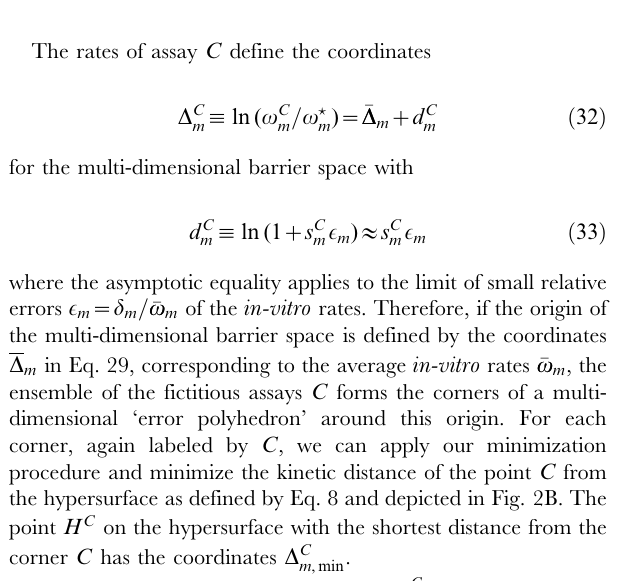
ribosome. The reactions were stopped at the indicated time intervals and translation products separated on 16.5% Tris- Tricine-PAGE and visualized by the fluorescent reporter BOD- IPY-Fl at the N-terminus of the peptides [47] (left panels). The intensity of the full length product was quantified with ImageJ (right panel, circles). Average translation rates per codon, which depend on the elongation rates only, were determined by exponential fitting (fits in graphs of the right panel). Figure S2 In-vitro rates as measured for near-cognate accommodation and rejection after proofreading. In- vitro values of the rates v 9,10 : k 5,nr and v 90 : k 7,nr for